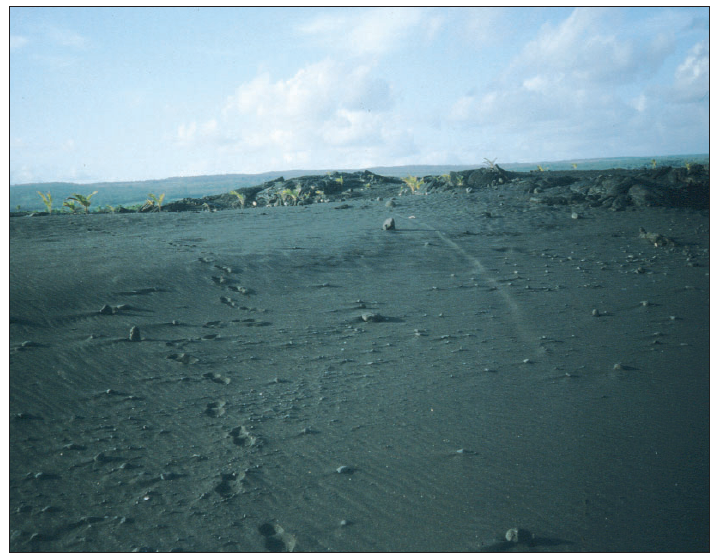
Fig. 1. Black sand beach, Kaimu, Big Island Hawaii,